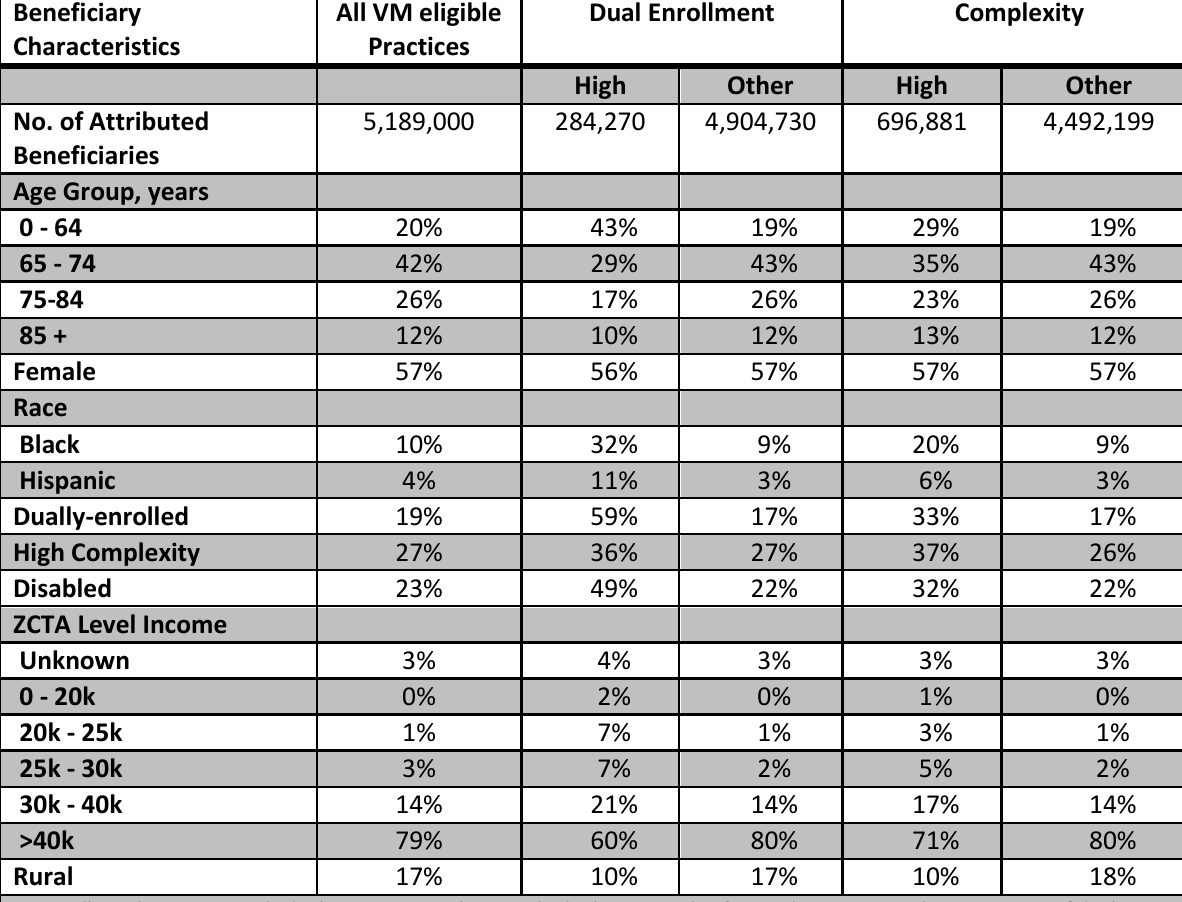
Table 10.3. Beneficiary Characteristics at Practices Caring for a High Proportion of Dually-Enrolled